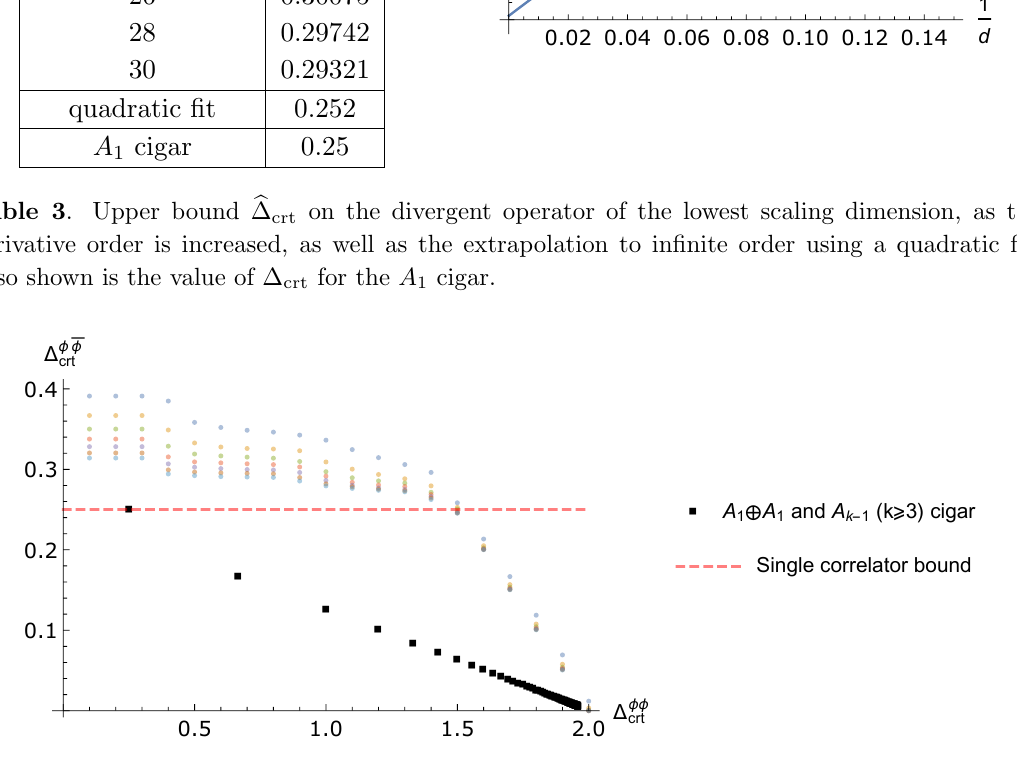
(cid:22) (cid:30) ; b (cid:1) (cid:30) ) on the divergent operator of the crt crt (cid:22) (cid:30) is bounded above by 2, beyond which (cid:1) (cid:30) = 0. The square crt crt A 1 (at (1 = 4 ; 1 = 4)) and A k (cid:0) 1 ( k 3) cigar theories. (cid:8) (cid:21)